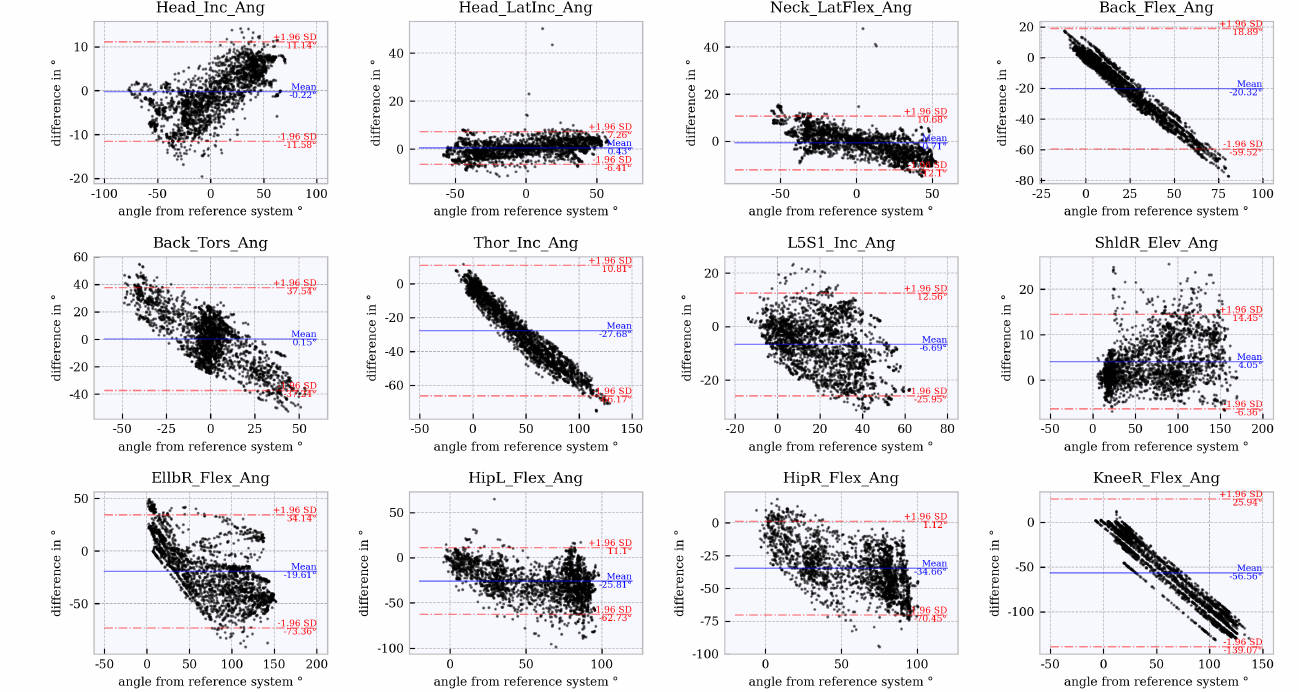
Figure A6. Bland–Altman plot for tracker configuration 3 from WIDAAN ; x does not show the average of both systems but the joint angles of the reference system, Qualisys.